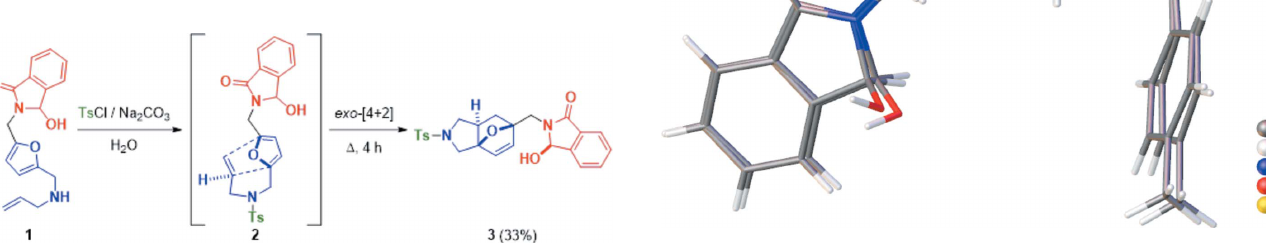
Figure 3 Overlay image of the two molecules ( A and B ) in the asymmetric unit of the title compound 3 .